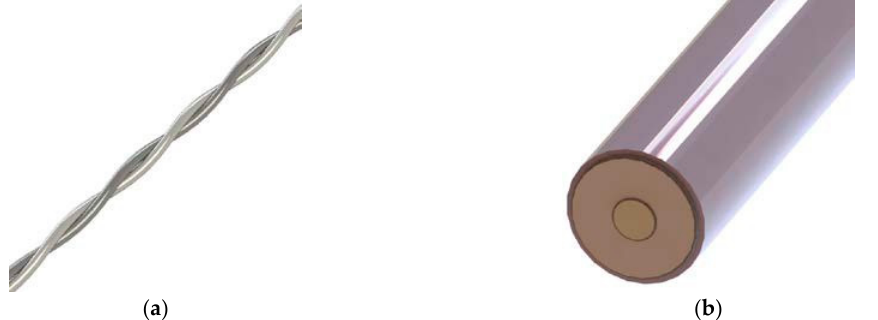
Figure 1. Schemes of suitable strand-based sensors for the use in the body of textiles ( a ) twisted electrode arrangement, ( b ) coaxial electrode